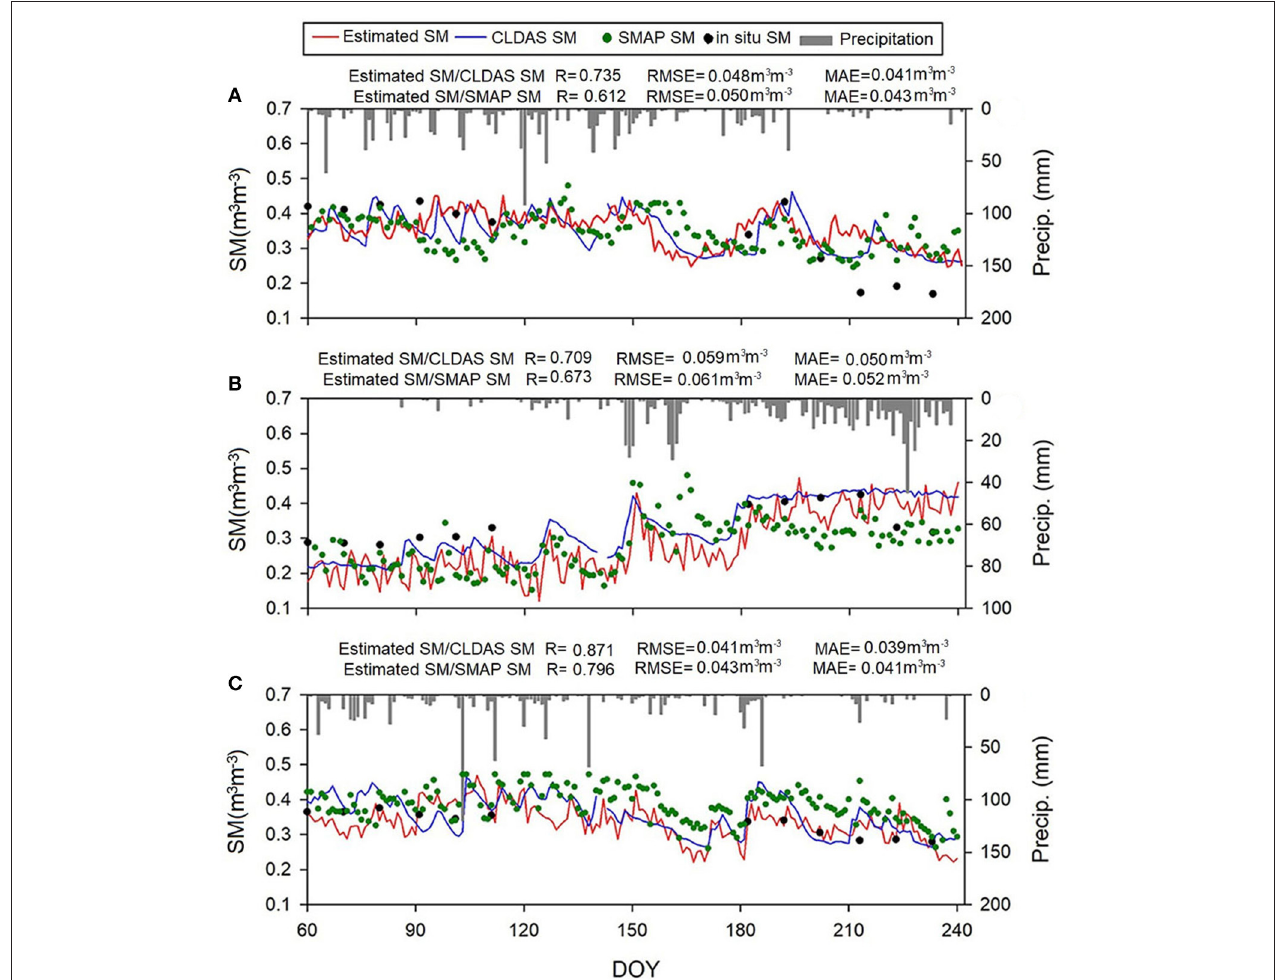
FIGURE 10 | Temporal variations in the estimated SM, CLDAS, and in situ SM at three validation sites, (A) is Hunan, (B) is Jiangxi, and (C) is Yunnan.